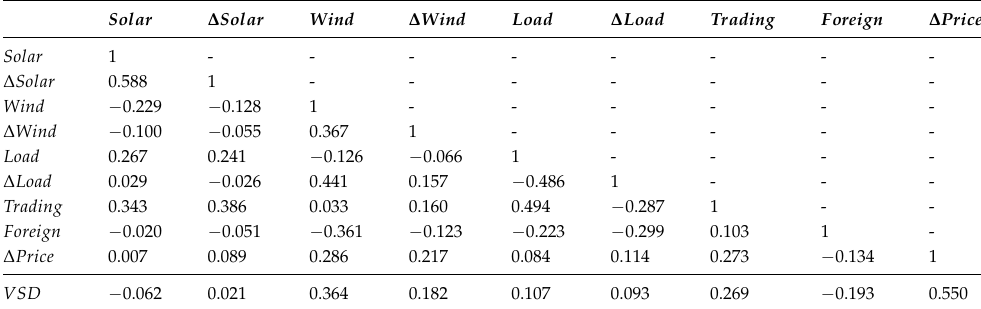
Table 4. Correlations between the explanatory variables and the volume-weighted average standard deviation VSD . Solar is the relative solar share of the total consumption, and ∆ Solar is the relative solar forecast error of the total consumption. Wind and ∆ Wind are analogously defined as the relative wind share and the relative wind forecast error of the total consumption. Load is the volume of the total consumption in TWh, ∆ Load is the unsigned relative excess generation over consumption in Germany, Trading is the traded volume of the intraday market in GWh, Foreign is the relative share of the volume (buy and sell) traded between Germany and a foreign country and the total traded volume of the intraday market, and ∆ Price is the absolute price difference of the day-ahead auction price and the volume-weighted average intraday price.